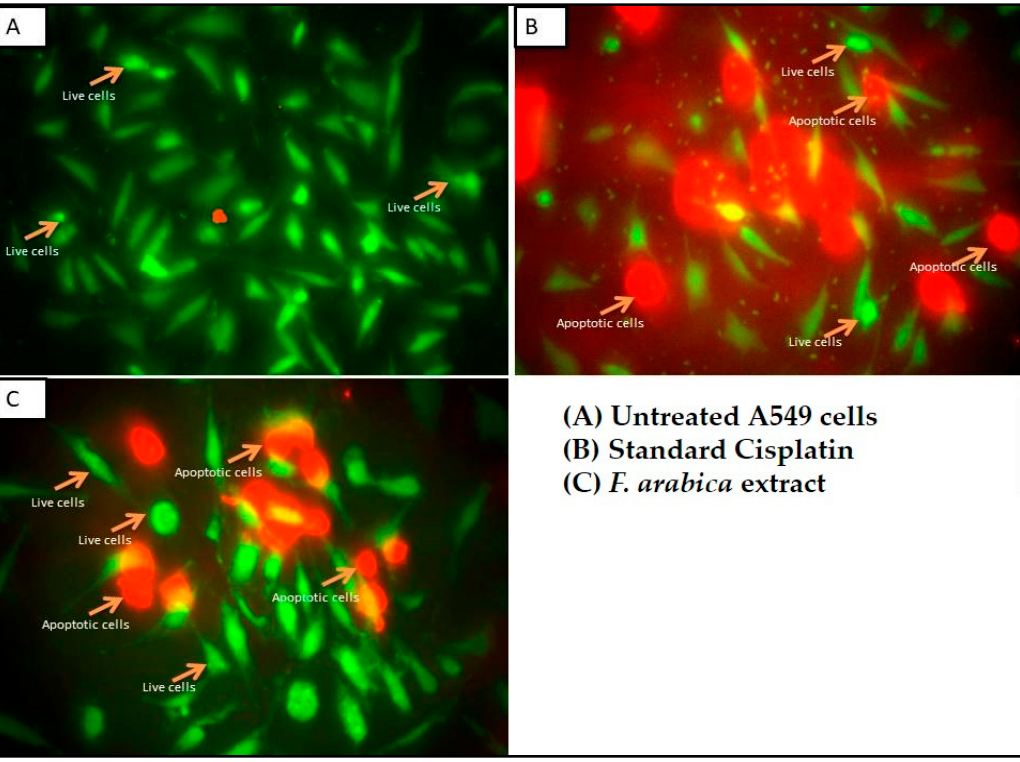
Figure 2. Detection of live and apoptosis cells in treated lung cancer A549 cells.